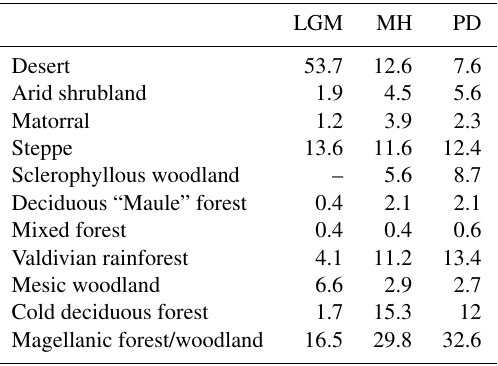
Table 2. Areal extent of biomes in the simulation domain (units: percent of total